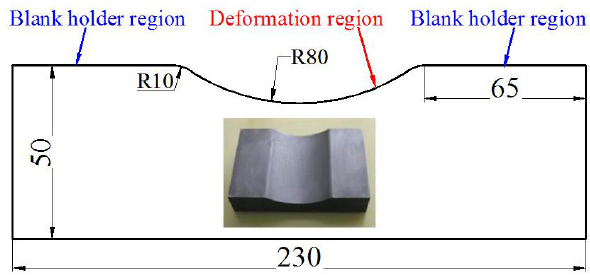
Figure 4. The single curvature die.